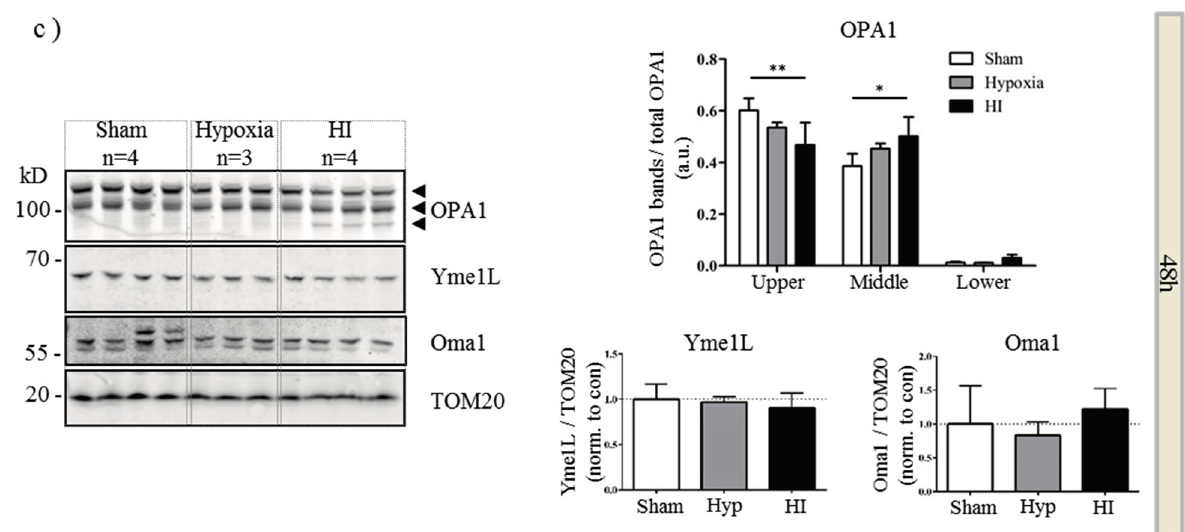
Figure 4. Aberrant processing of OPA1 in vivo. Mitochondrial fractions were generated from hypoxic-ischemic (HI), hypoxia alone or sham control mice. Proteins were resolved by SDS-PAGE and analyzed by western blot for OPA1, Yme1L and Oma1 at 0 ( a ), 24 ( b ) and 48 h ( c ) following HI. Tom20 was used as a loading control for mitochondria (bottom panel). Total OPA1 expression was determined by densitometry and OPA1 isoforms or cleavage products expressed as a proportion of that total. Arrowheads indicate alternate forms of OPA1. Mean data shown ± SD. OPA1 significance was determined by two-way ANOVA for band size and treatment followed by a Bonferroni post-hoc test * p < 0.05, ** p < 0.01, *** p < 0.001, **** p < 0.0001. YME1L and Oma1 data were analyzed with a one-way